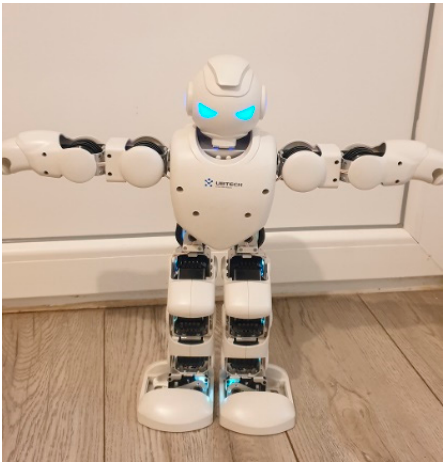
Figure 18. Alpha 1 P robot.